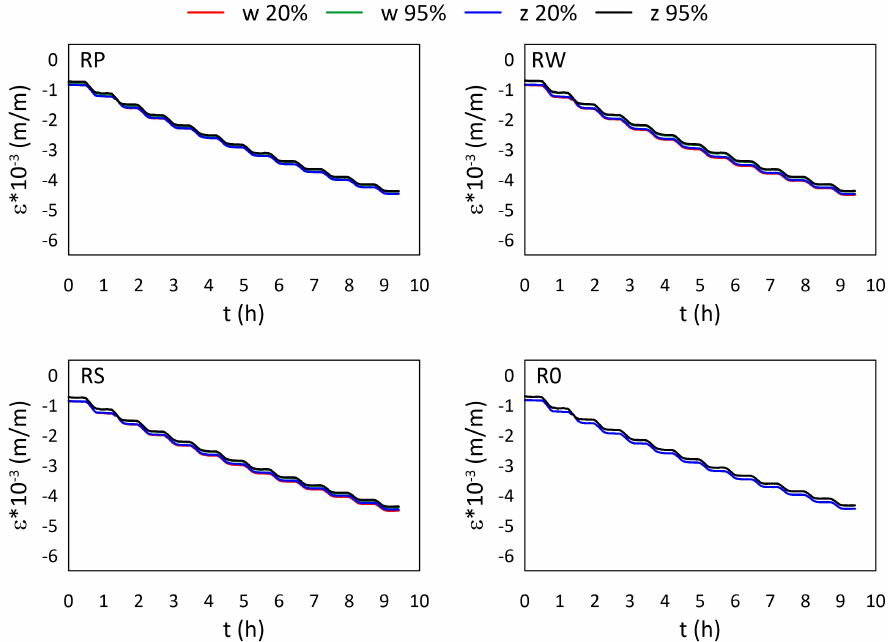
Figure 6. Strain measured by FBG sensors for M3 X samples under sub-zero temperatures; FBG sensors: w —embedded, and z